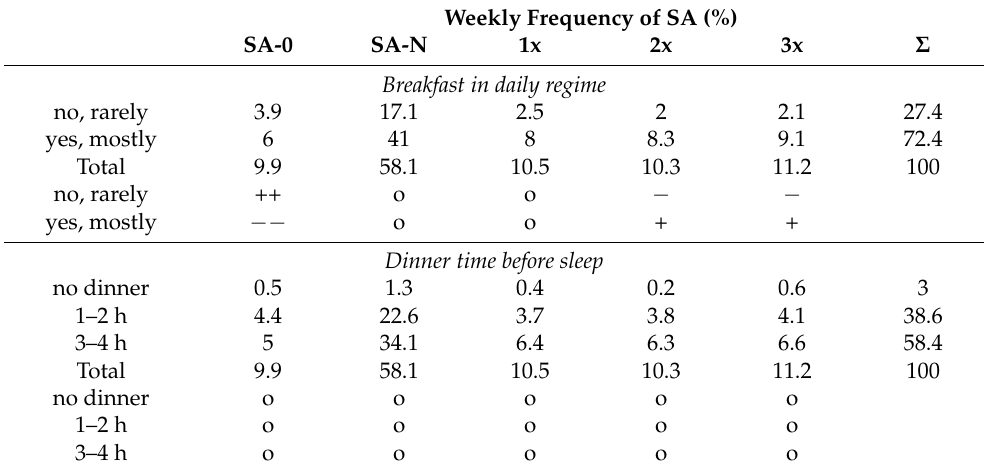
Table 6. Relation between consumption of breakfast in the daily regime, dinner time, and frequency of